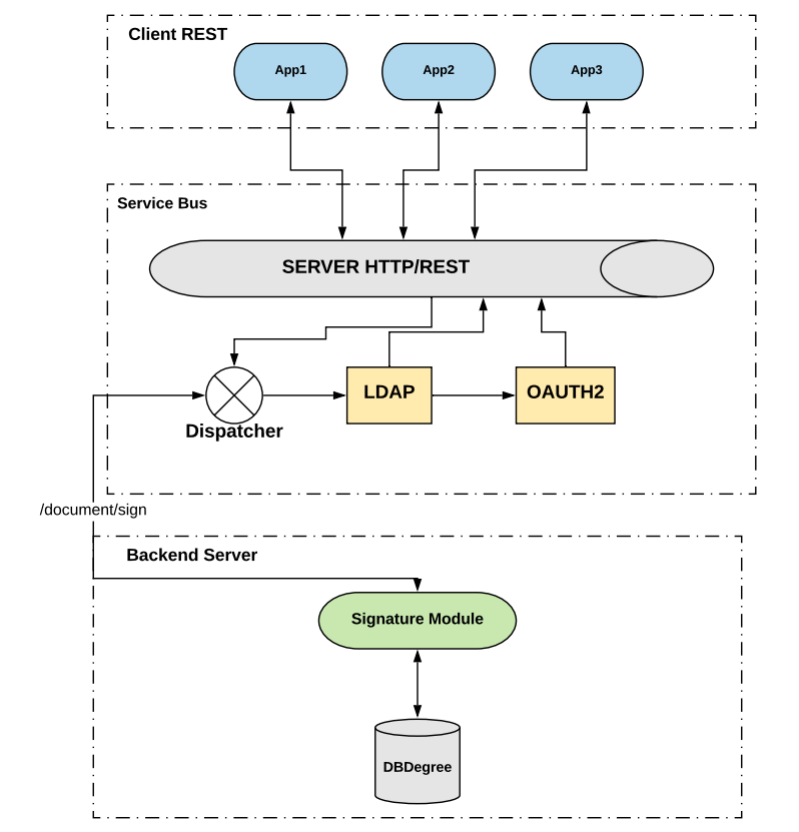
Figure 4. Service bus diagram.